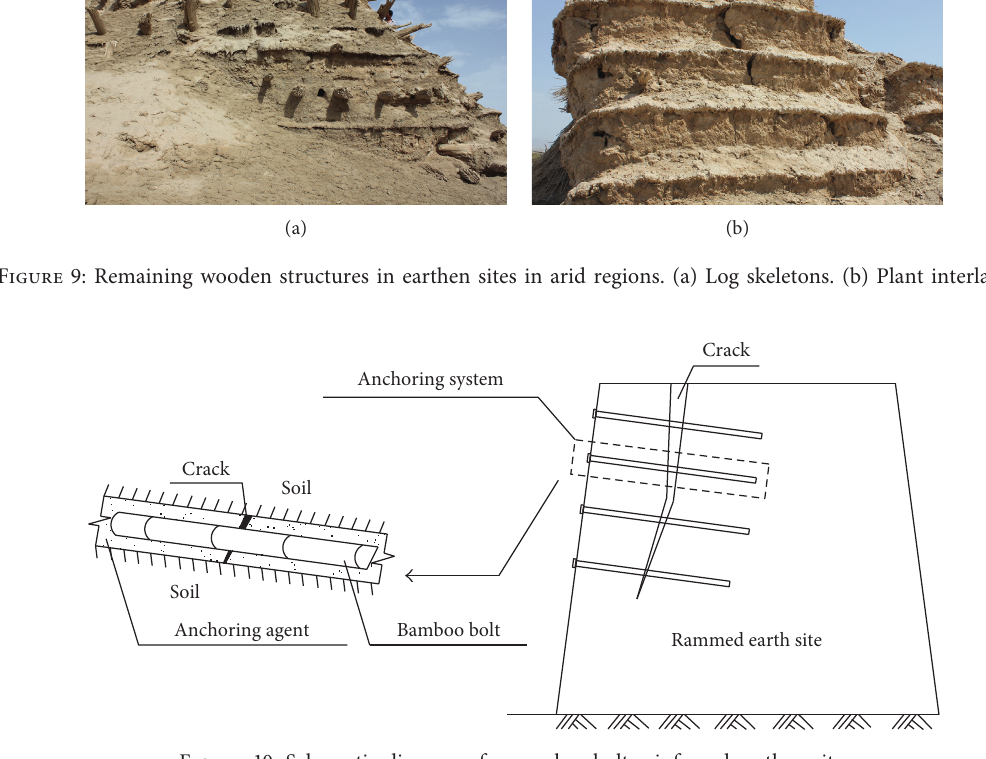
Figure 10: Schematic diagram of an anchor bolt-reinforced earthen